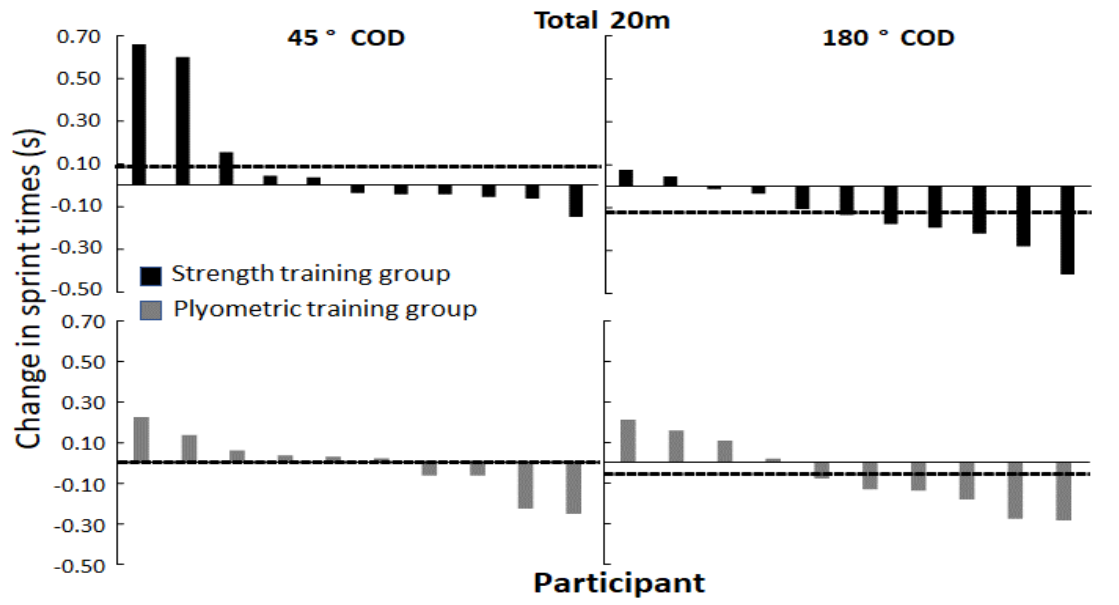
Figure 4. Individual responses displayed in seconds for both the strength and plyometric training groups in the 45° and 180° COD test at total COD test (20 m). Average change in performance within the group is marked by a dotted line.